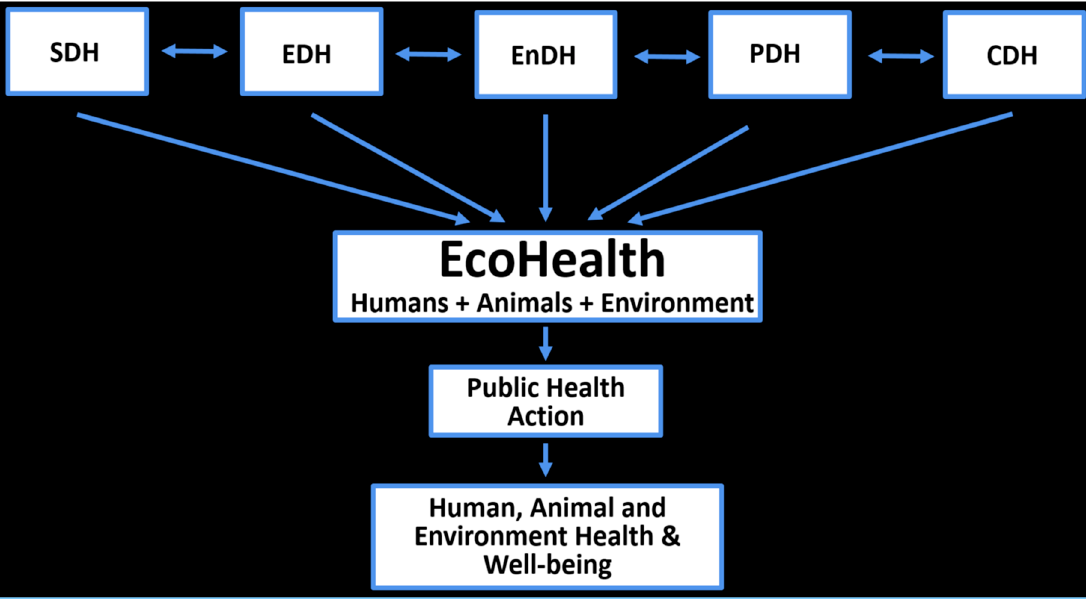
Figure 2. New Analytic Framework on the Determinants of Health and EcoHealth.